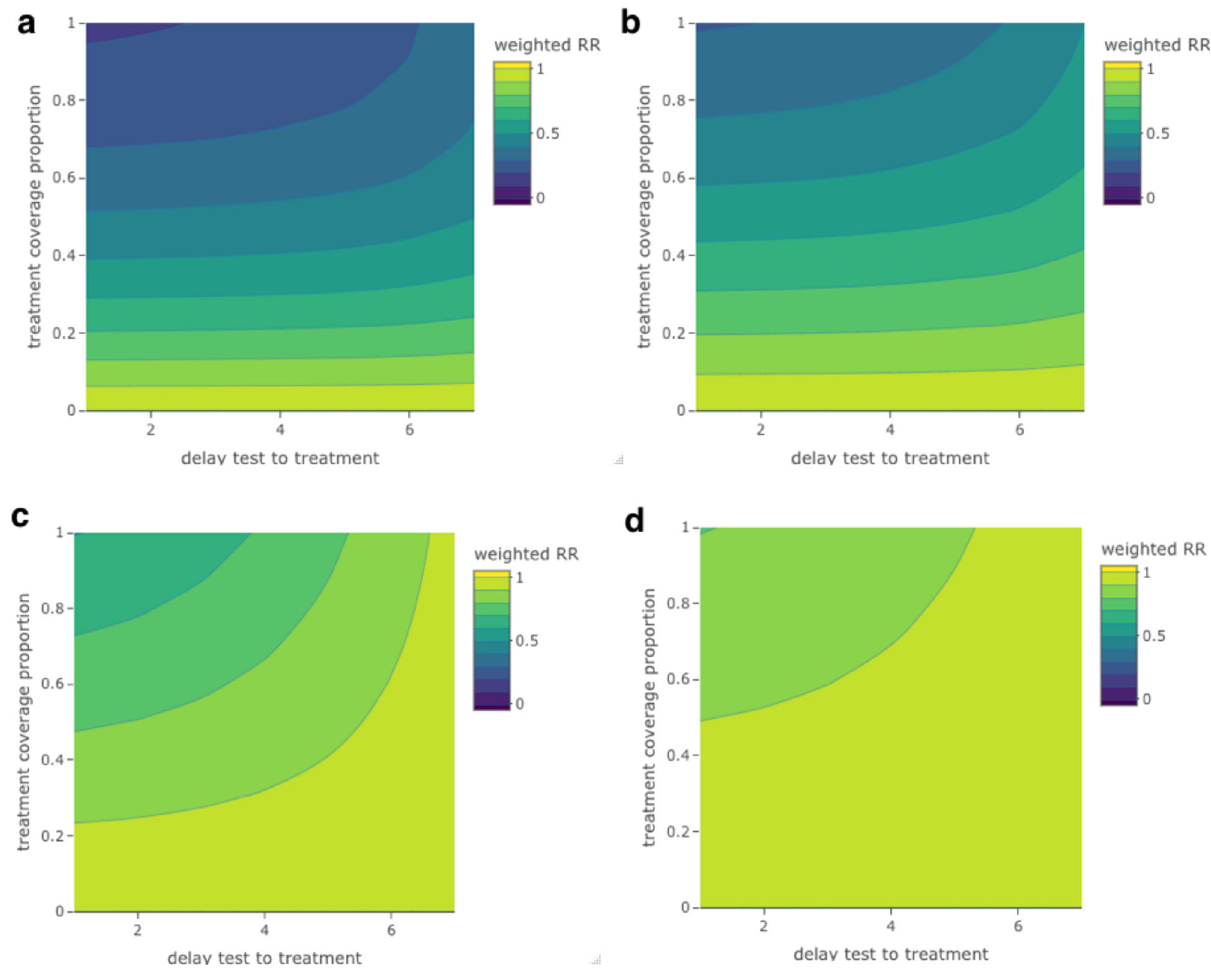
Fig. 2 | Sensitivity of estimated weighted hospitalization risk ratios (weighted RR), relative to the patient population untreated with nirmatrelvir, to treat- ment coverage and treatment delays, across testing strategies. The weighting of RRs re fl ects the likelihood of testing positive and therefore being treated with nirmatrelvir x days after becoming infected. Sensitivity of estimated